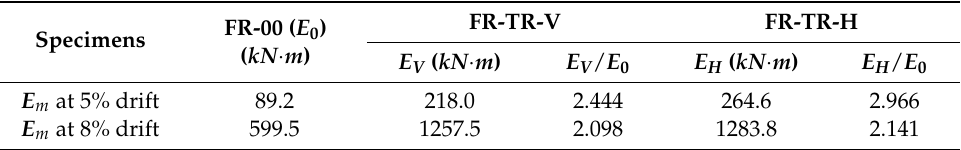
Figure 13. Cumulated energy dissipation curves of the specimens. Table 4. Cumulated energy (cid:2161) (cid:3040) of the specimens.